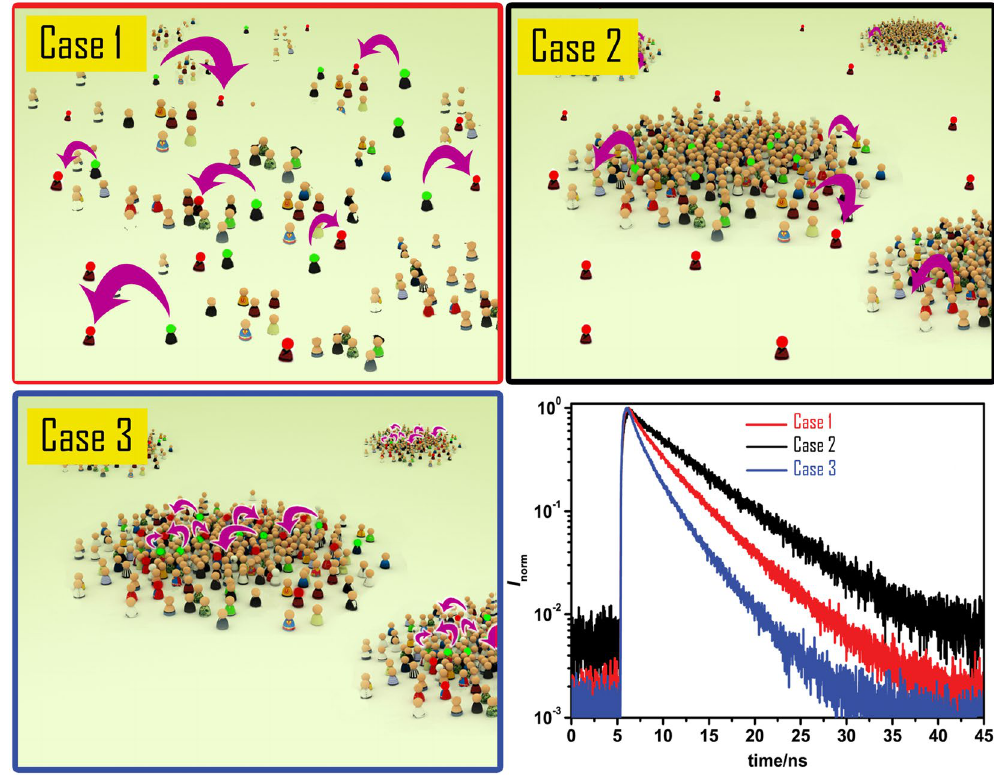
Figure 1. Figure depicting the basic principles underlining the detection of domains by FRET. When donors (green) and acceptors (red) are homogeneously distributed on a plane at sufficiently high acceptor concentration (Case 1) FRET occurs and speeds up the relaxation of the donors back to the ground state. If formation of domains influences the distribution of probes, i.e. when the probes possess different affinity for the domains and the remaining part of the bilayer, two scenarios are possible: Case 2 where the donors accumulate in the domains and acceptors are excluded from them leading to separation of the donors from the acceptors and thus to a decrease in the FRET efficiency and consequently to slower relaxation to the ground state (compare the black with the red decay in the bottom right corner); Case 3 where the accumulation of the donors and acceptors in the nanodomains results in more efficient FRET and consequently to faster relaxation to the ground state (compare the blue with the red decay in the bottom right corner). Bottom right: Examples of the fluorescence decays of the donors in each case. The decays are influenced by the size of the domains, the fractional area occupied by the domains and by the affinity of the probes for the domains; the readouts which can be determined by fitting the experimental decays by using MC-FRET